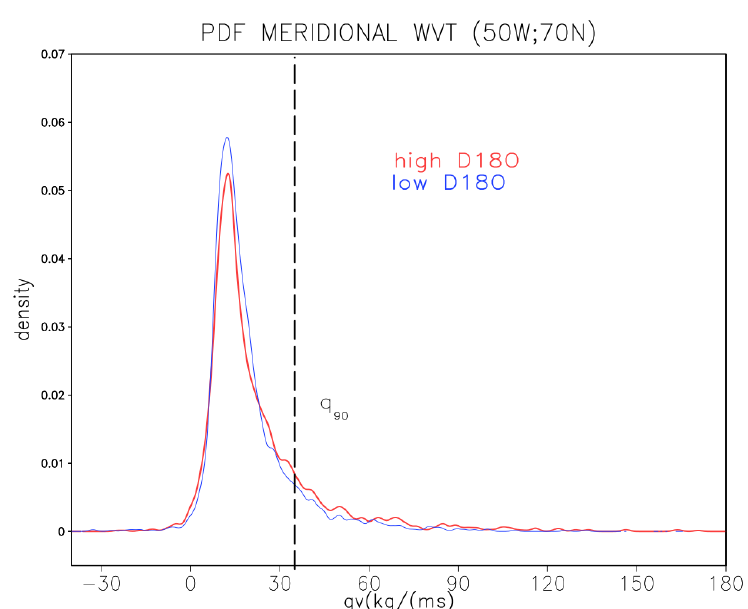
Figure 2. The probability density function of daily meridional water vapor transport at (50 ◦ W, 70 ◦ N) for high (red) and low (blue) ice core δ 18 O winters during 1851 to 1973. Dotted vertical line depicts the 90th percentile of the all winter day meridional WVT distribution.